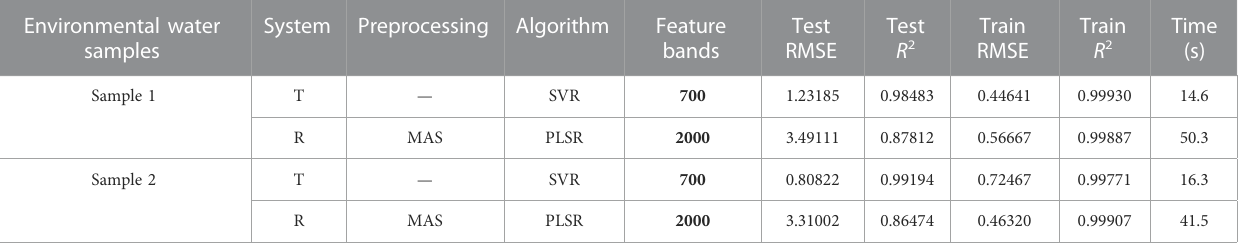
TABLE 8 Environmental water sample modeling results. Environmental water